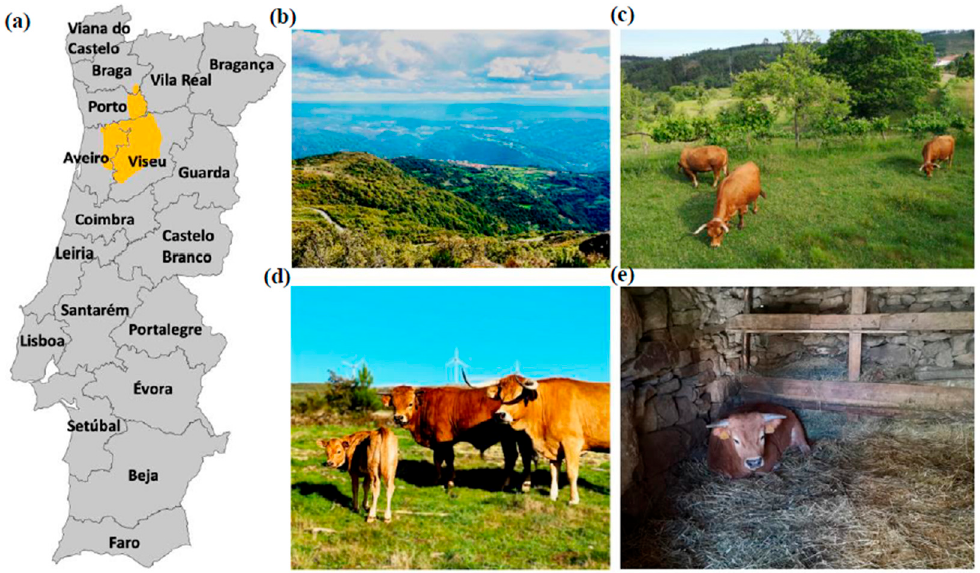
Figure 1. ( a ) Production area of Arouquesa breed; ( b ) Montemuro mountain landscape where is possible to observe the Lameiros pastures; ( c ) Arouquesa herd grazing in a Lameiro ; ( d ) Animals in a Lameiro (From the left to the right, an Arouquesa calve, a weaner and a cow); ( e ) Sheds where the calves are kept.